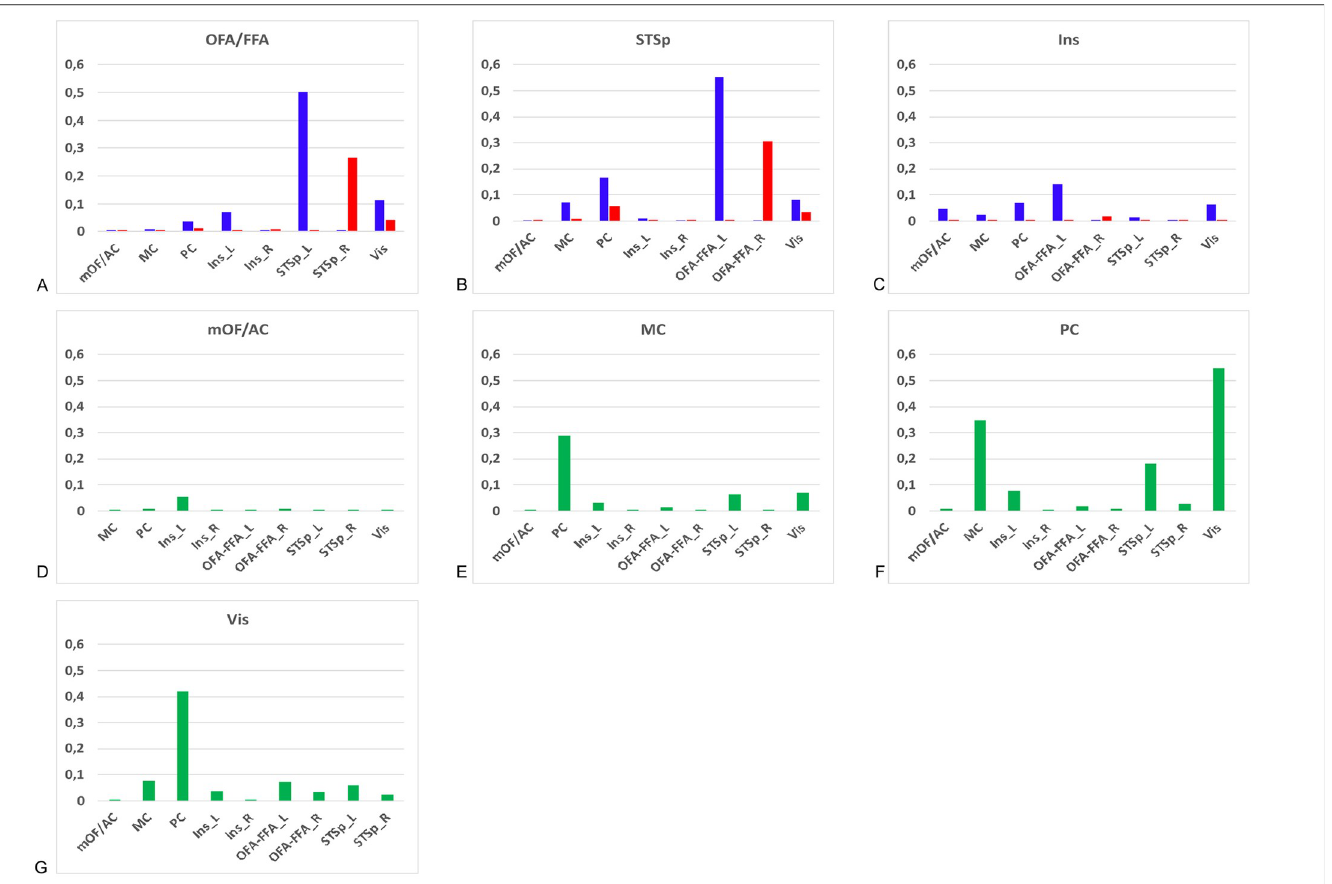
Fig 7. Connectivity probability among regions of interest (ROI) that belong to face processing system. Histograms represent the normalized number of streamlines leaving each seed region towards the target regions. Core system areas: A) Occipital face area-Fusiform face area (OFA/FFA) and B) posterior Superior Temporal Sulcus (STSp); Extended system areas: C) Insula (Ins), D) medial Orbito-frontal cortex/Anterior cingulate (mOF/AC), E) medial cingulate (MC), F) posterior cingulate (PC) and G) Visual cortex (Vis). L: Left hemisphere (blue), R: right hemisphere (red).